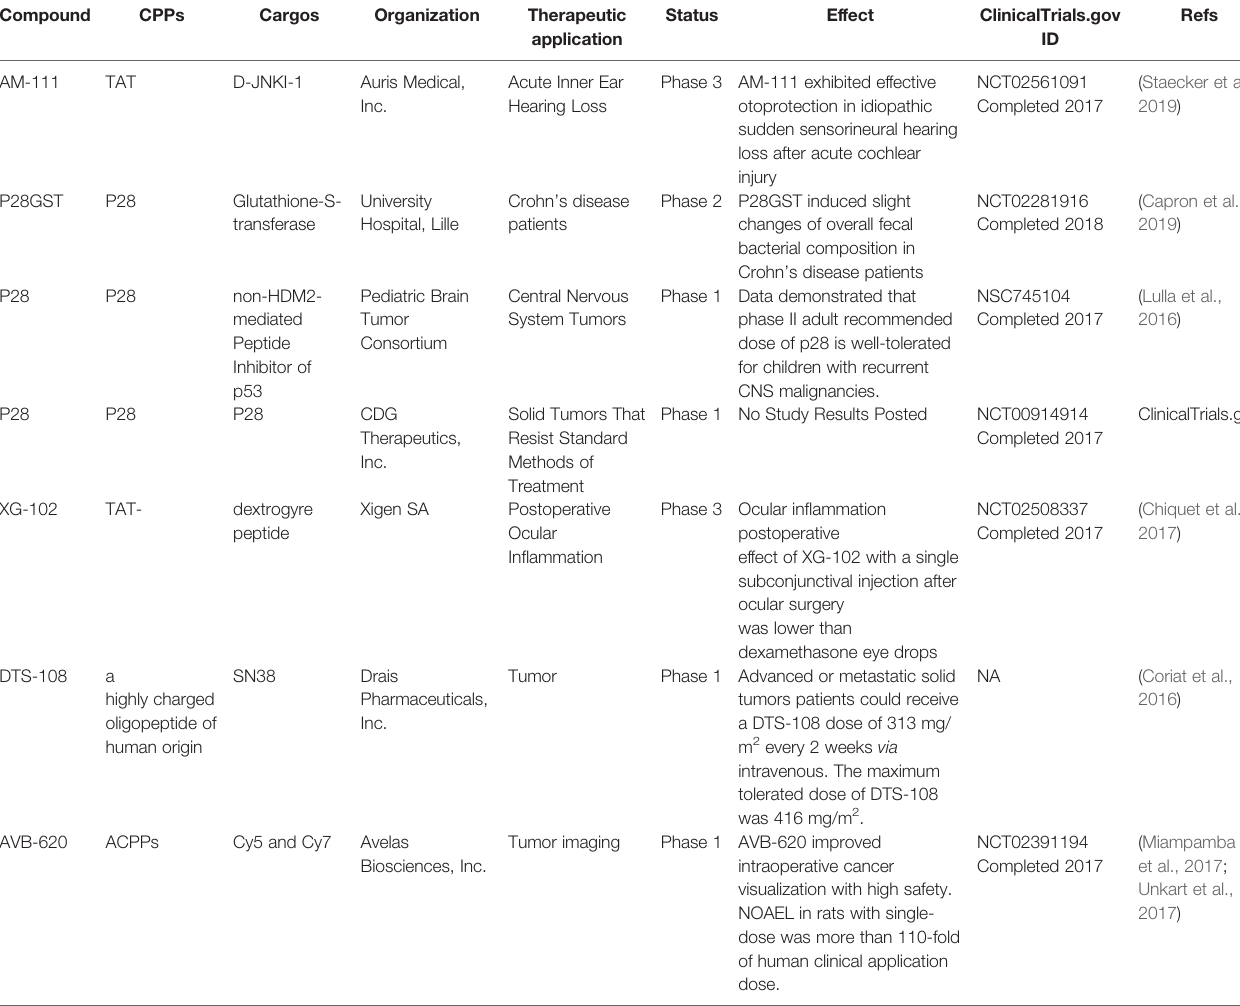
TABLE 2 | Examples of CPP-conjugated therapeutics under clinical